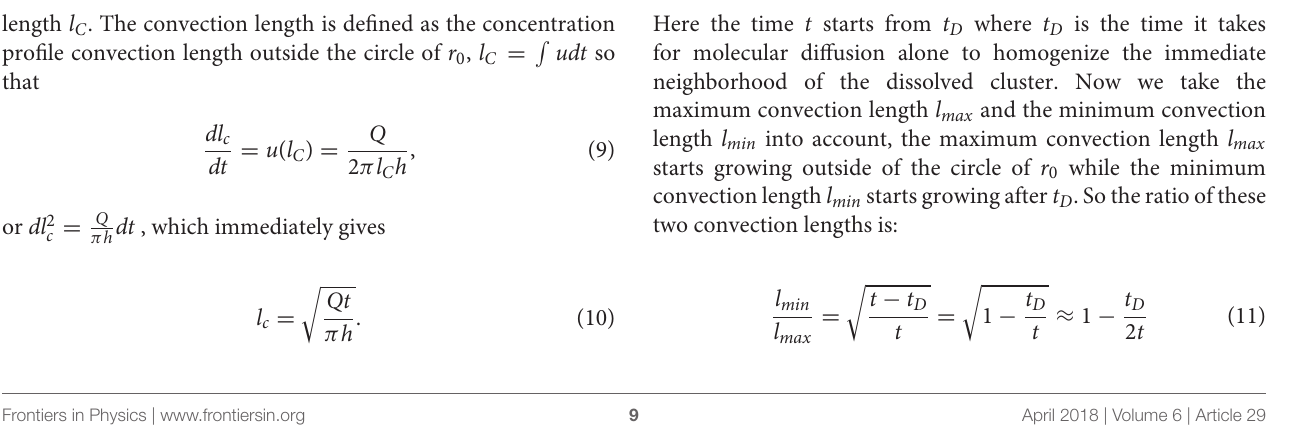
length l C . The convection length is defined as the